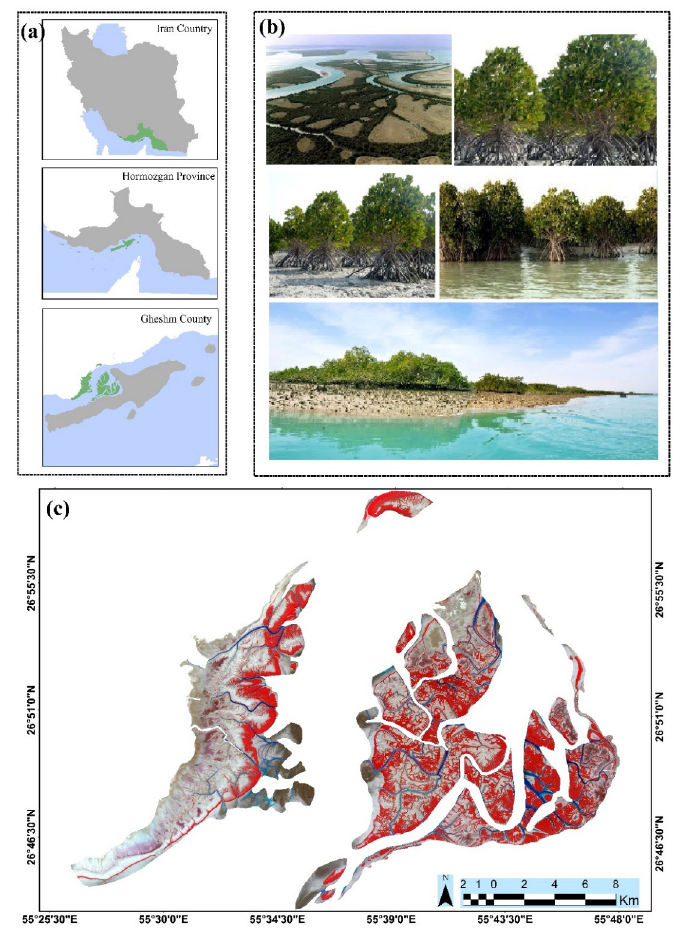
Figure 1. a – Location of the study area; b – in situ photos of mangrove forests; c – infrared color composite image from Landsat